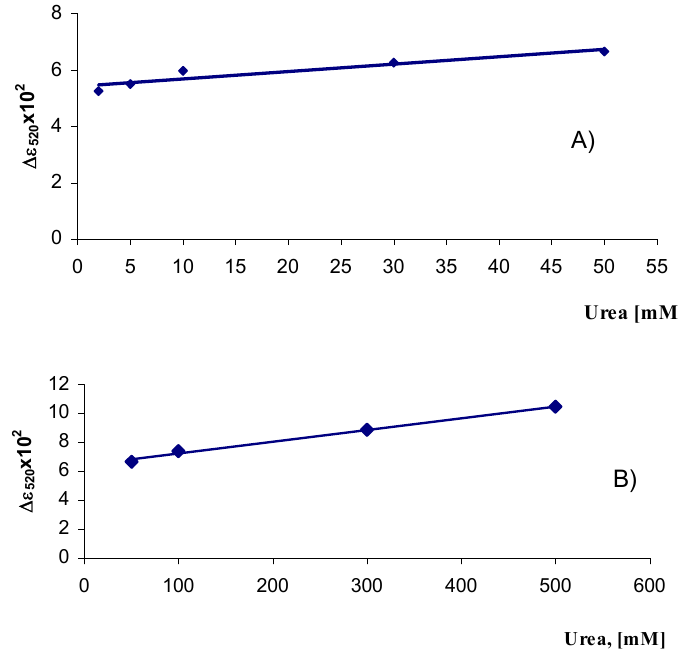
FIGURE 3 . Standard curve for determination of the amount of urea using free enzyme and indicator immobilized on a triacetylcellulose membrane; in the range of 2 to 50 mM (3A); 50 to 500 mM